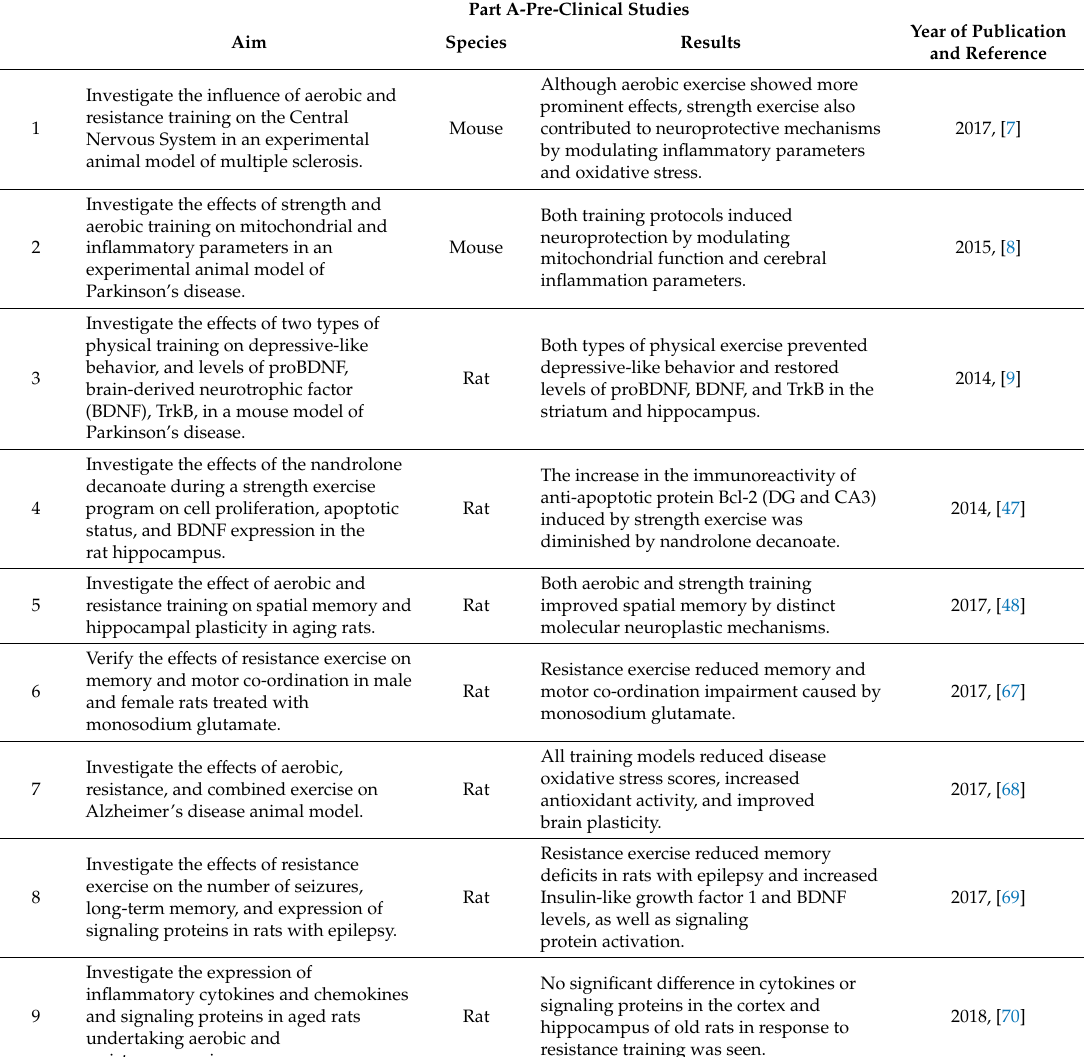
Table 1. Recent pre-clinical (part A) and clinical (part B) studies related to the e ff ects of resistance (or strength) training on the brain.